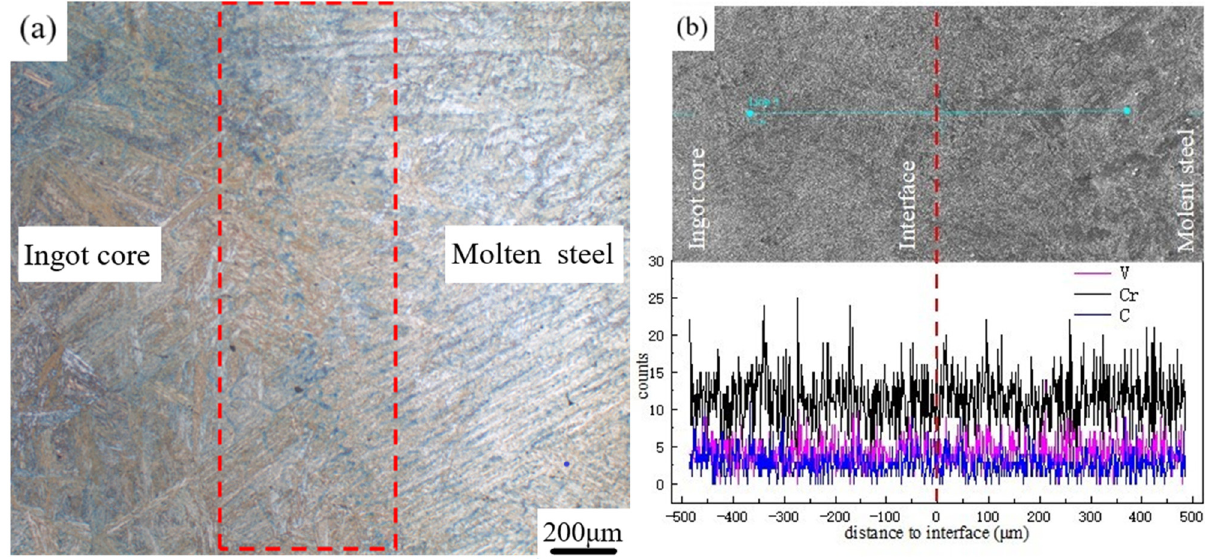
Figure 12: Metallographic structure and element distribution of solid – liquid interface at the bottom of coated steel ingot: ( a ) interface metallographic structure; ( b ) interface element